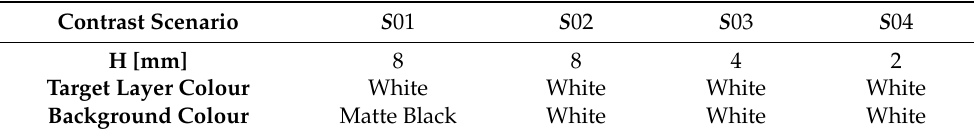
Table 1. Experimental set